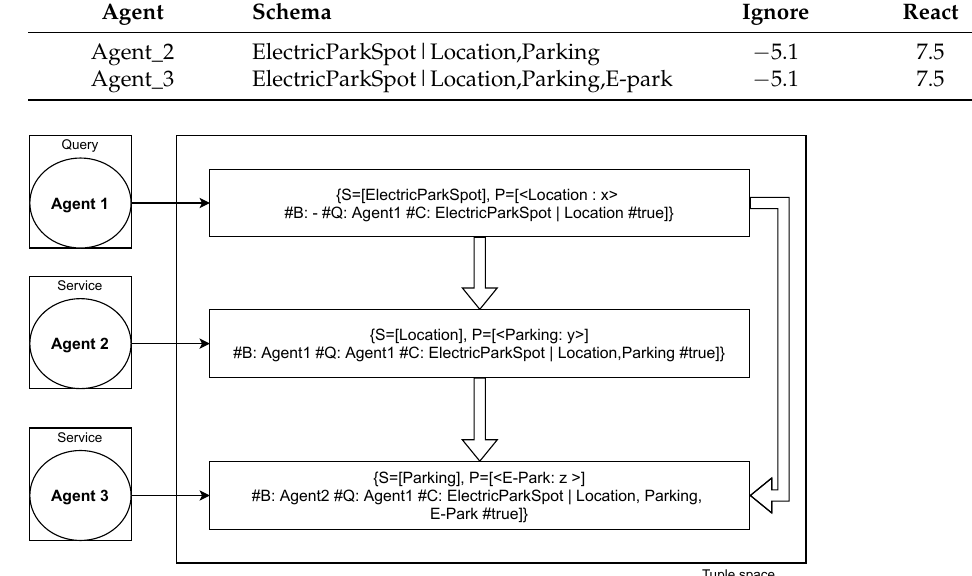
Figure 6. Semantic composition diagram of the electric car parking